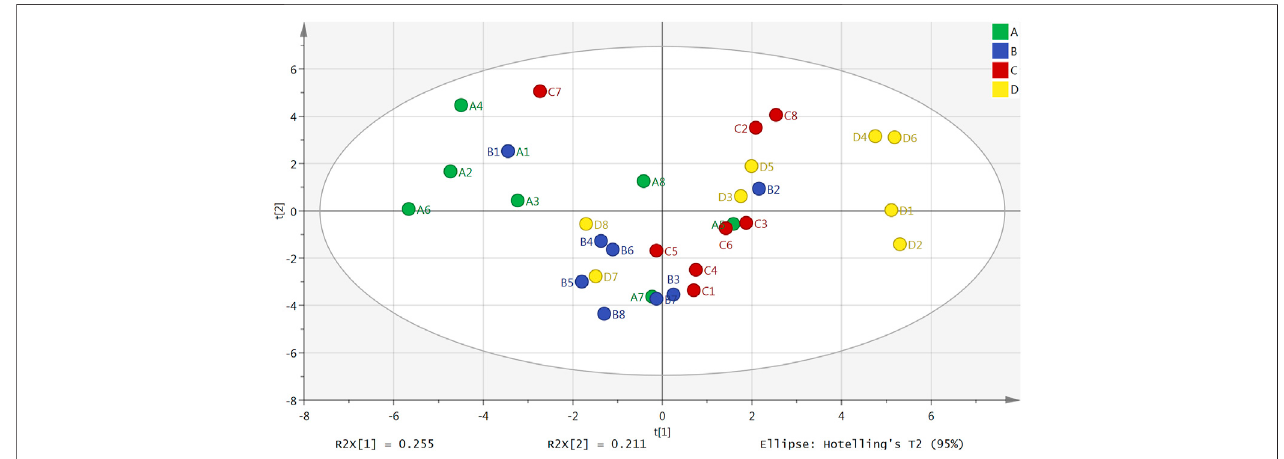
FIGURE 2 | PCA scores plot of the normal group (A), model group (B), Borneol essential oil group (C), and reference group (D) in brain tissue samples ( n = 8).